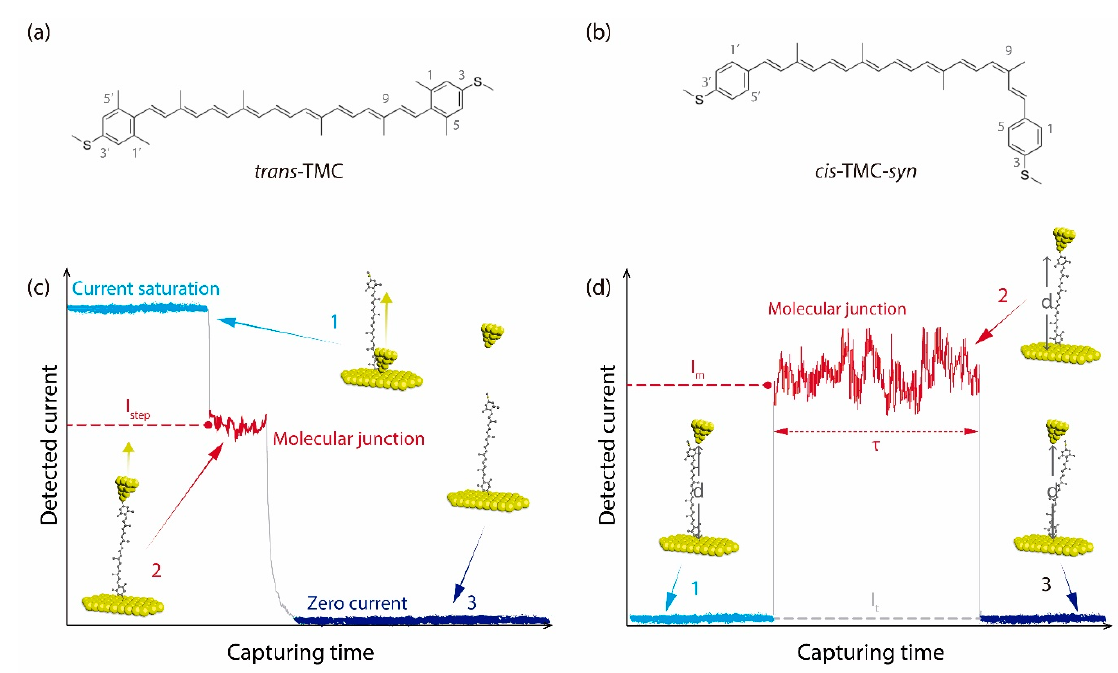
Figure 1. ( a ) Trans -TMC (terminal 1,5-dimethyl-3-methylthiophenyl) and ( b ) cis -TMC-syn synthesized molecules. ( c ) Sche- matic of the dynamic BJ approach: (1) current saturation; tip and substrate in contact, (2) current plateau at I step due to the formation of a molecular junction during tip retraction, (3) zero current (junction breakdown) stage when the tip is pulled away from the surface and the molecule detaches from one electrode. ( d ) Schematic of the blinking approach: (1) fixed inter-electrode distance, d, at a pre-defined tunnelling current, I t . (2) current blink at, I m due to the spontaneous formation of a molecular junction (with a finite lifetime τ ), (3) current drop to I t upon spontaneous molecular junction breakdown.